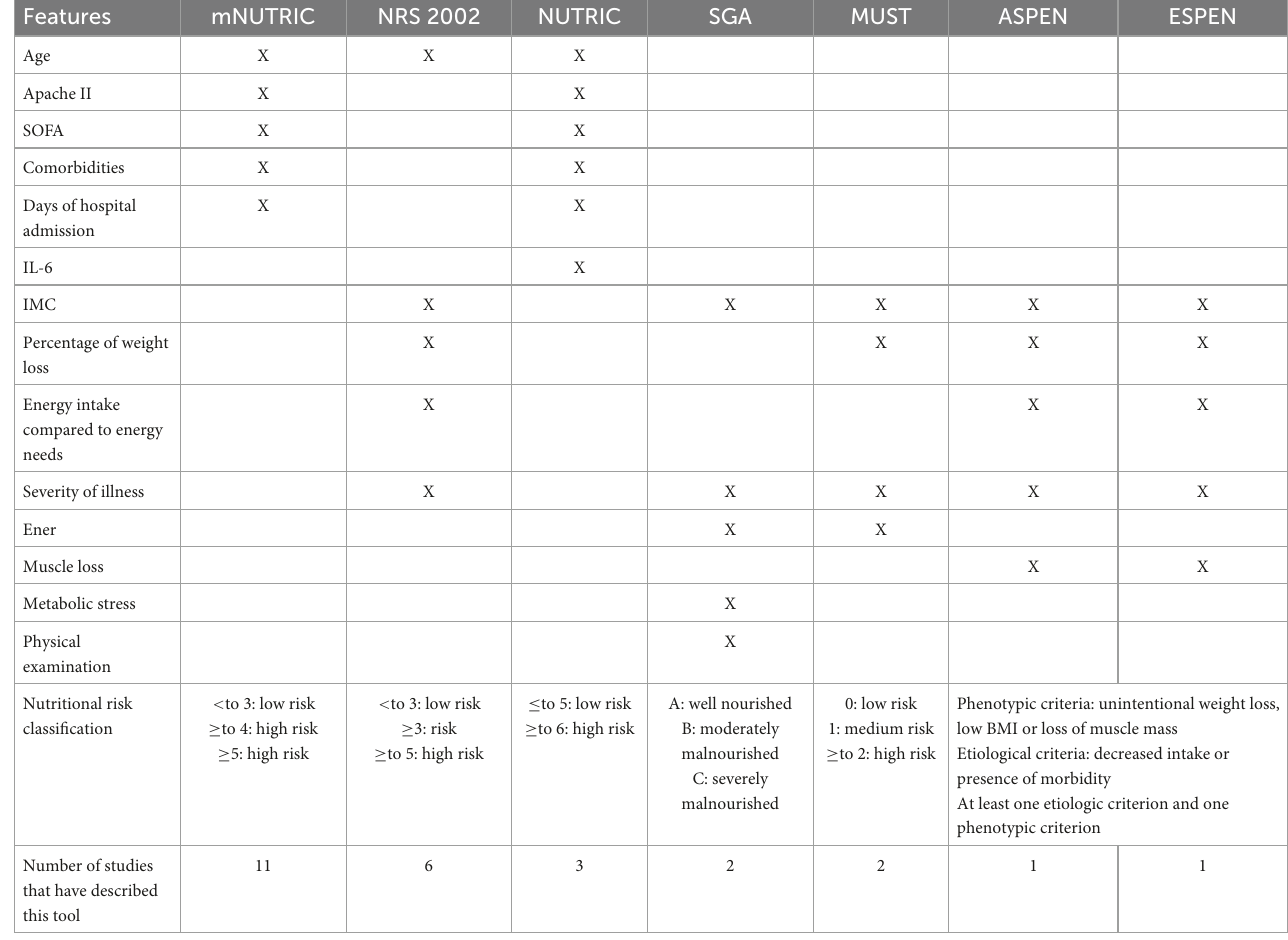
TABLE 3 Components of the different screening